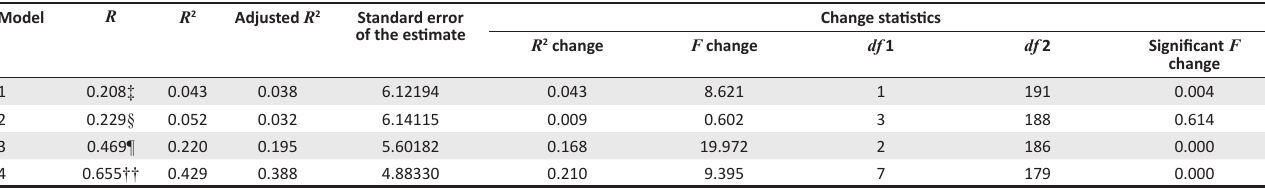
TABLE 2: Model summary. † Model R R 2 Adjusted R 2 Standard error